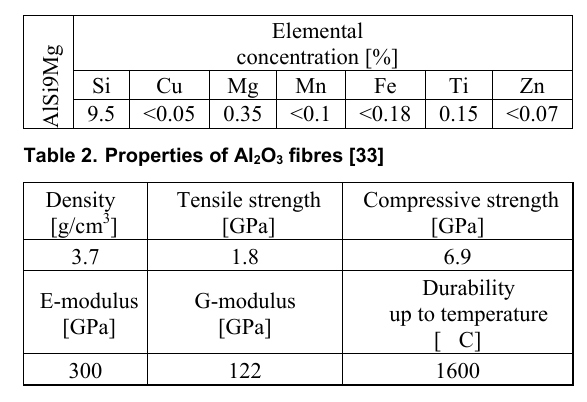
Table 1. Chemical composition of alloy AlSi9Mg [33].